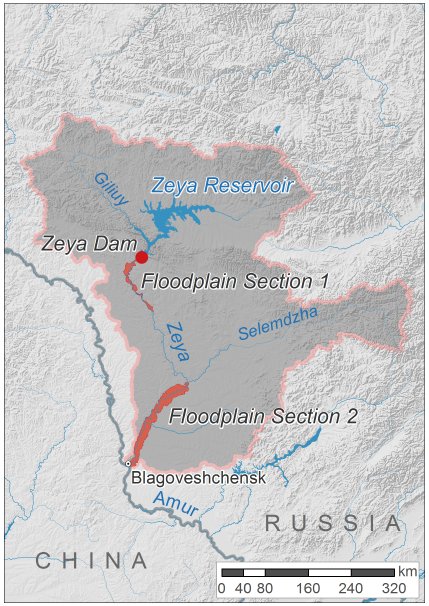
Figure 3. Location of the wide floodplain sections described in this